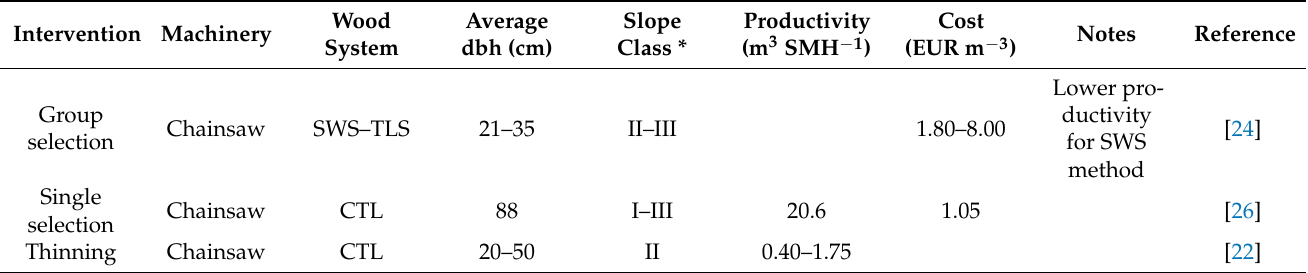
Table 1. Summary of data from the reviewed studies dealing with felling operations. Empty cells indicate that that parameter was not immediately retrievable from the given